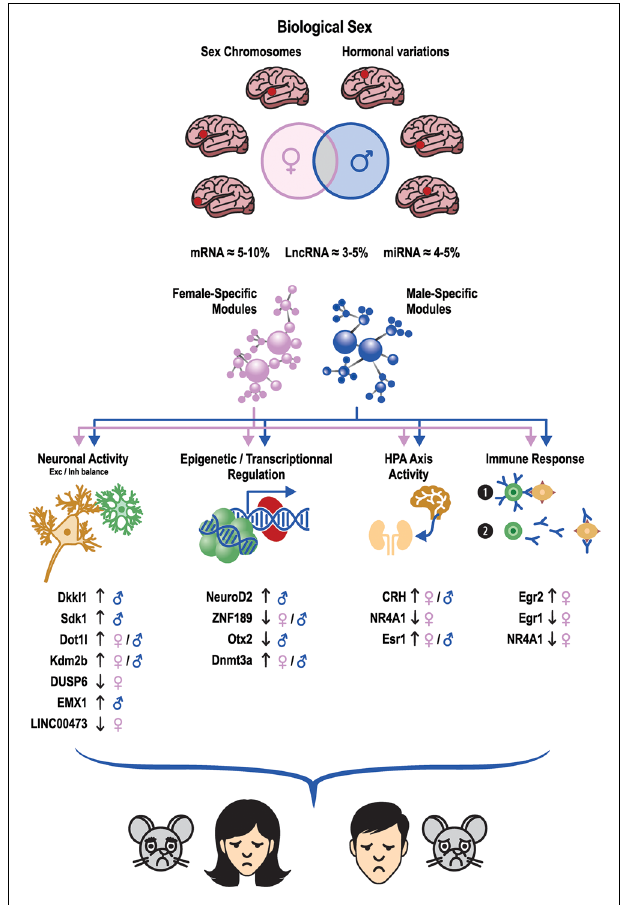
FIGURE 2 | Males and females with MDD or stress share minimal transcriptional overlap across brain regions. These sex differences may be driven by biological factors such as sex chromosomes and hormonal variations. Similar differences are also observed at the gene network level where sex-specific transcriptional networks are associated with the expression of MDD in either males or females in humans but also with the expression of stress susceptibility or resilience in stressed male and female mice. These transcriptional changes interfere with the activity of several molecular, biological, and cellular processes such as neuronal activity, epigenetic and transcriptional regulation, the function of the HPA axis, and immune response. Ultimately, this leads to the expression of converging depressive-like behaviors in males and females sharing similar symptomatic and behavioral features. The orientation of the arrows next to listed genes indicates whether gene expression is upregulated or downregulated in the depressed/stressed